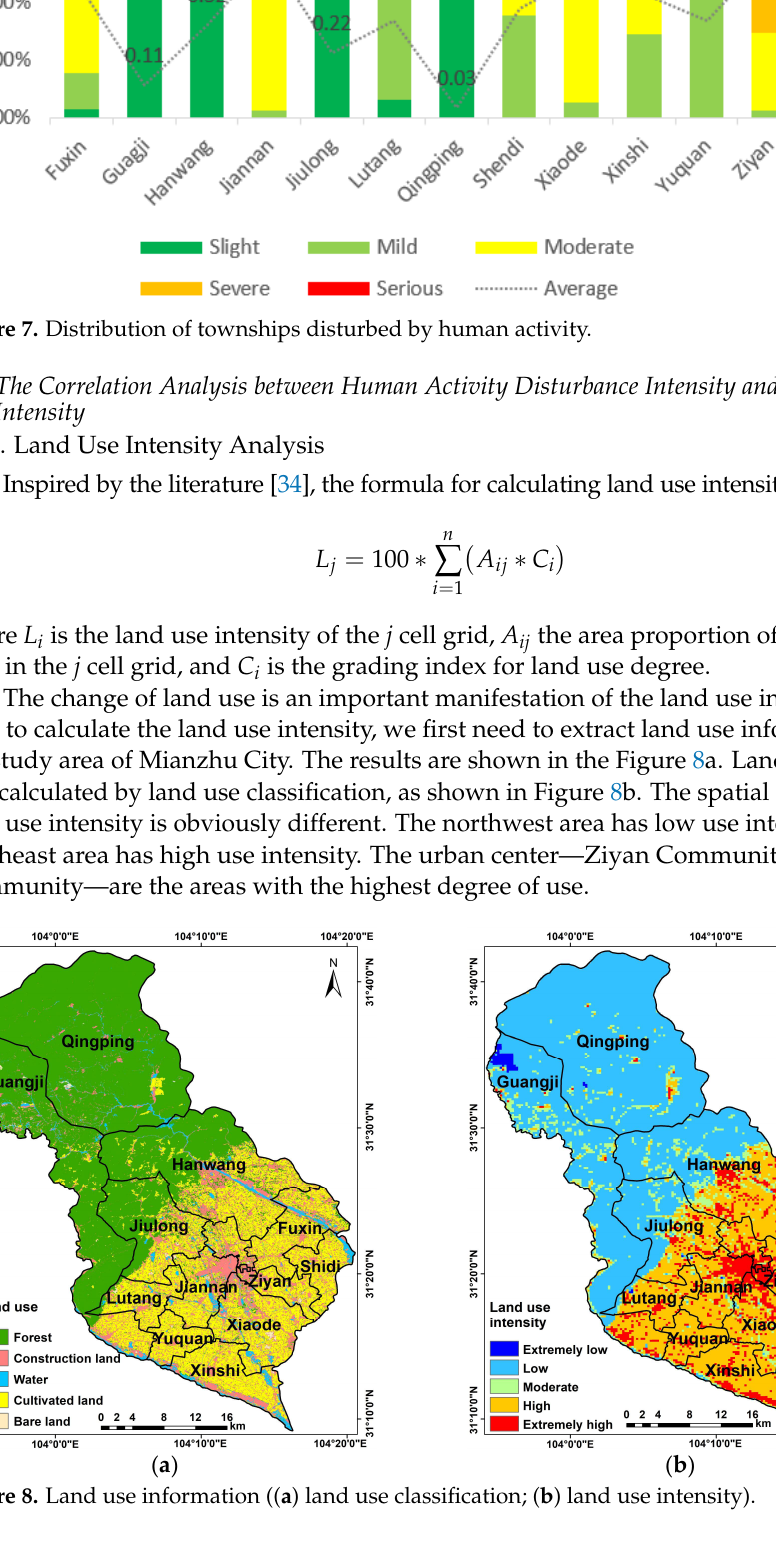
( b ) Figure 6. Spatial autocorrelation of human activity disturbance intensity (( a ) Moran scatter plot of human activity disturbance; ( b ) LISA clustering map). Judging from the distribution of the township according to the Figure 7, the human activity disturbance intensities on Ziyan Community and Jiannan Community were similar. The disturbance intensity of the human activity in Qingping Town was the lowest, with an average disturbance intensity of only 0.03, and there was no severe disturbance or serious disturbance in this area, with slight disturbance as the mainstay. The